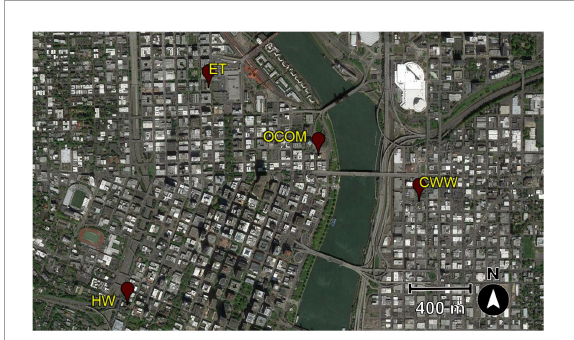
FIGURE1 Google Earth image (map data 2015 © Google) of Portland, Oregon from the year of the study (2015) with the locations of the four green roof sites used in this study marked. ET, EcoTrust; OCOM, Oregon College of Oriental Medicine; CWW, Central Wine Warehouse; HW, Hamilton